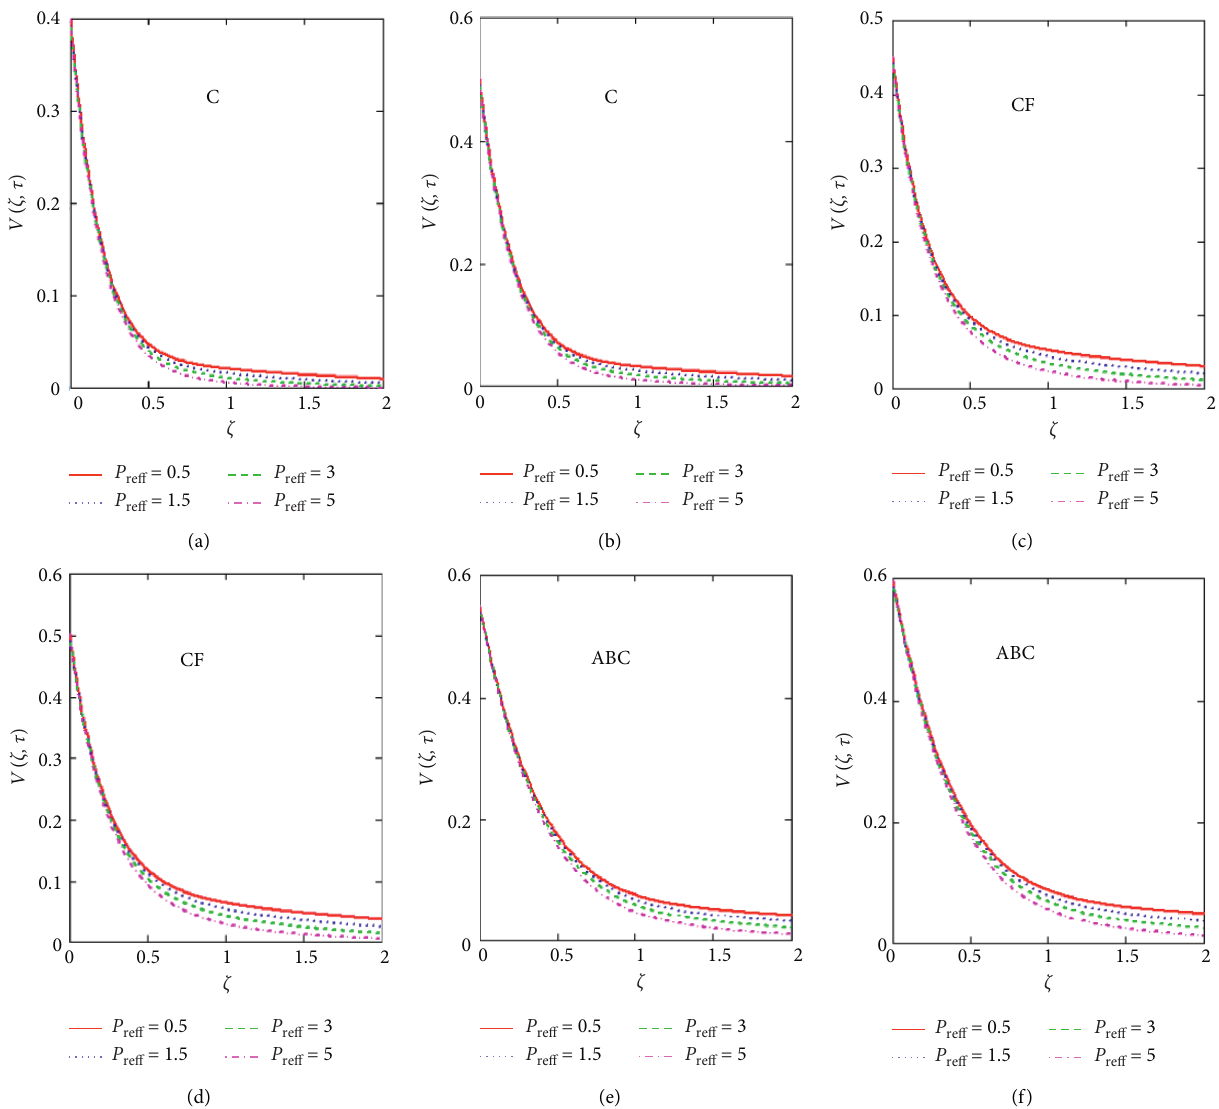
Figure 8: Plot via C, CF, and AB approaches for velocity with different values of P